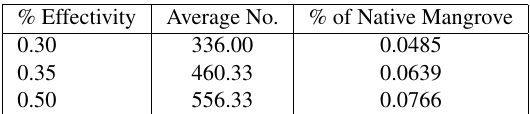
Table 1: Average number of mangroves in sprayed